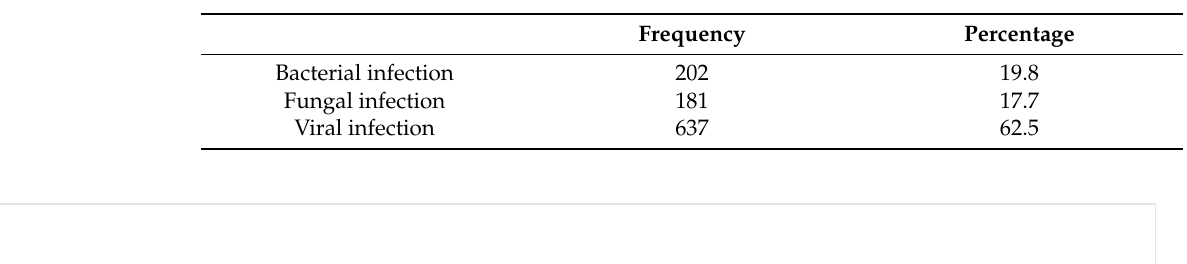
Table 2. Participants’ awareness of the monkeypox virus and disease.